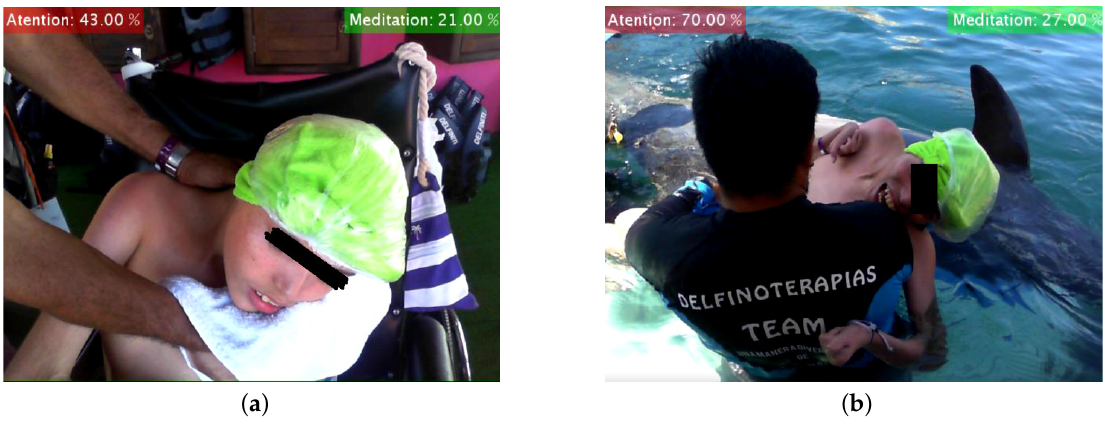
Figure 6. Method for obtaining EEG RAW samples. ( a ) ISCP patient At Rest or Before. ( b ) ISCP patient During a Dolphin-Assisted